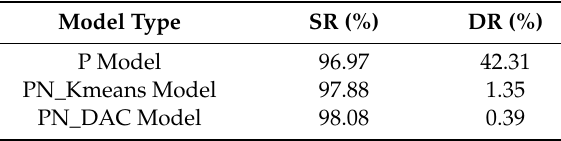
Table 2. Results of the